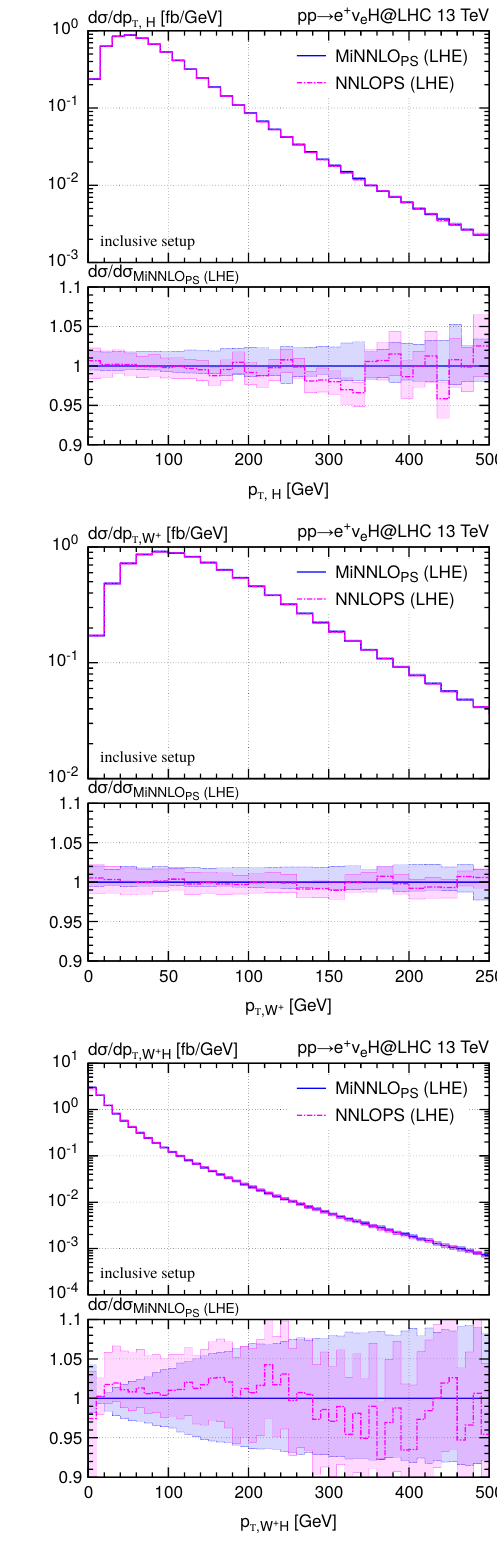
Figure 2 . Comparison of MiNNLO PS and NNLOPS predictions for e + ν e H